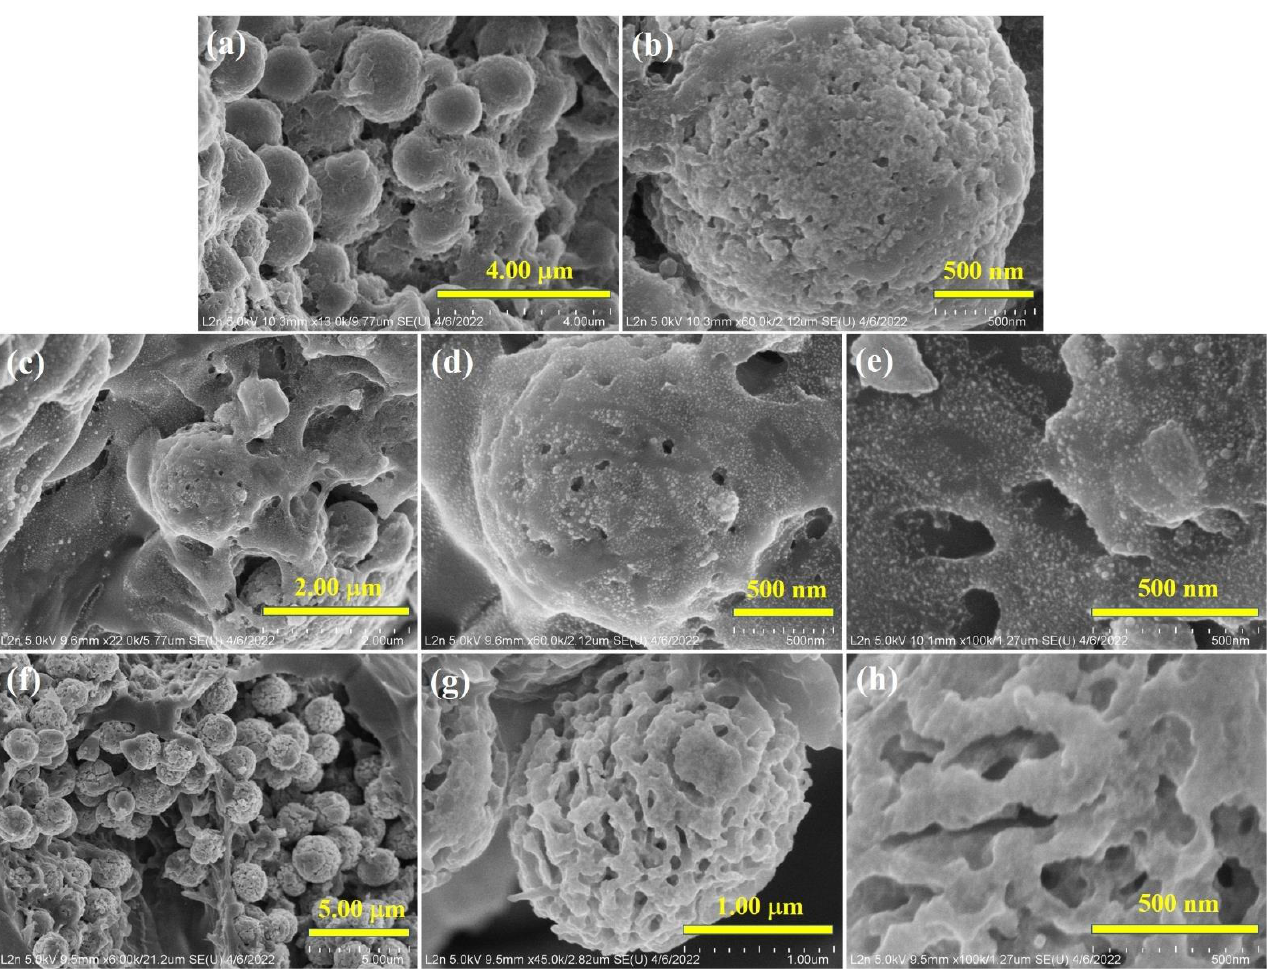
Figure 7. FESEM images of ( a , b ) B-CM, ( c – e ) B-MP, and ( f – h ) B-W.